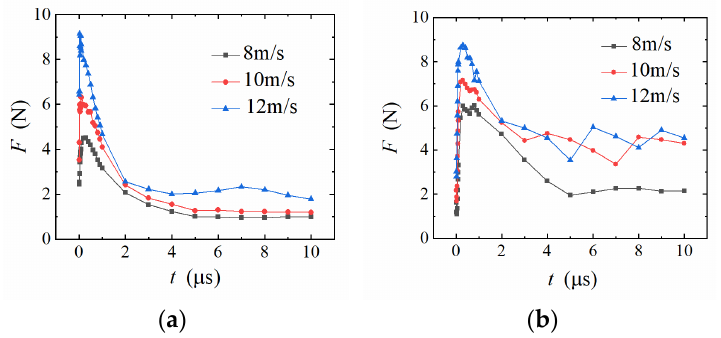
Figure 9. Wall force variation diagram: ( a ) flat wire; ( b ) circular wire.